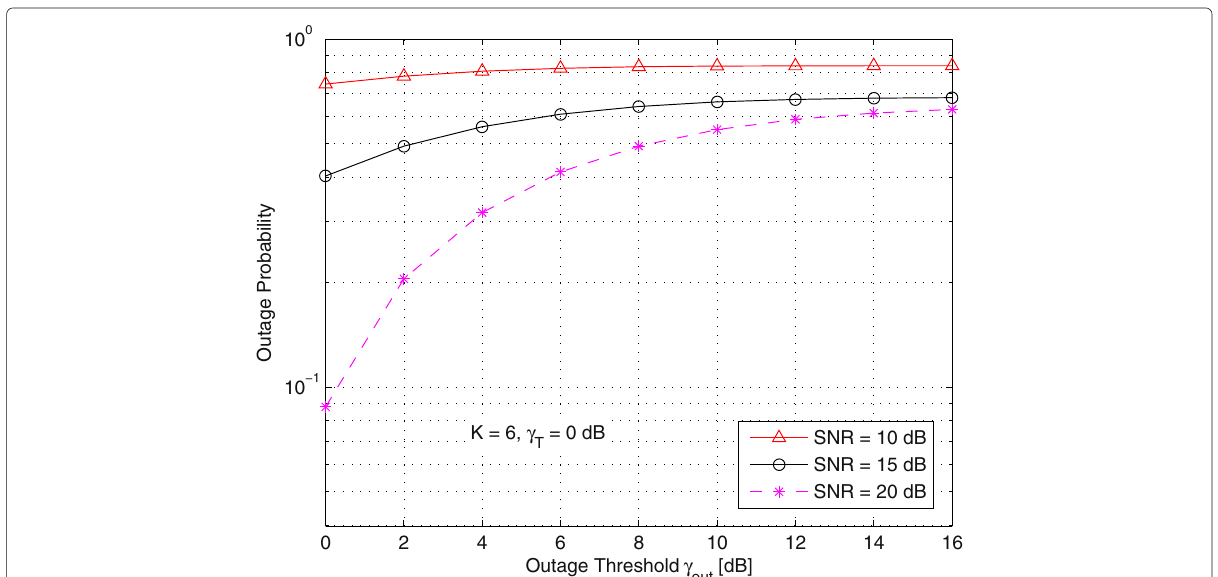
Fig. 5 Outage probability vs outage threshold of cognitive AF relay network with MUSwiD user selection scheme for different values of I p / N 0 and = 60, and (cid:3) = 0.8, (cid:3) = 0.9, (cid:3) = 0.7 for k = 1, ... (cid:3) s,p s,r r,p r, k